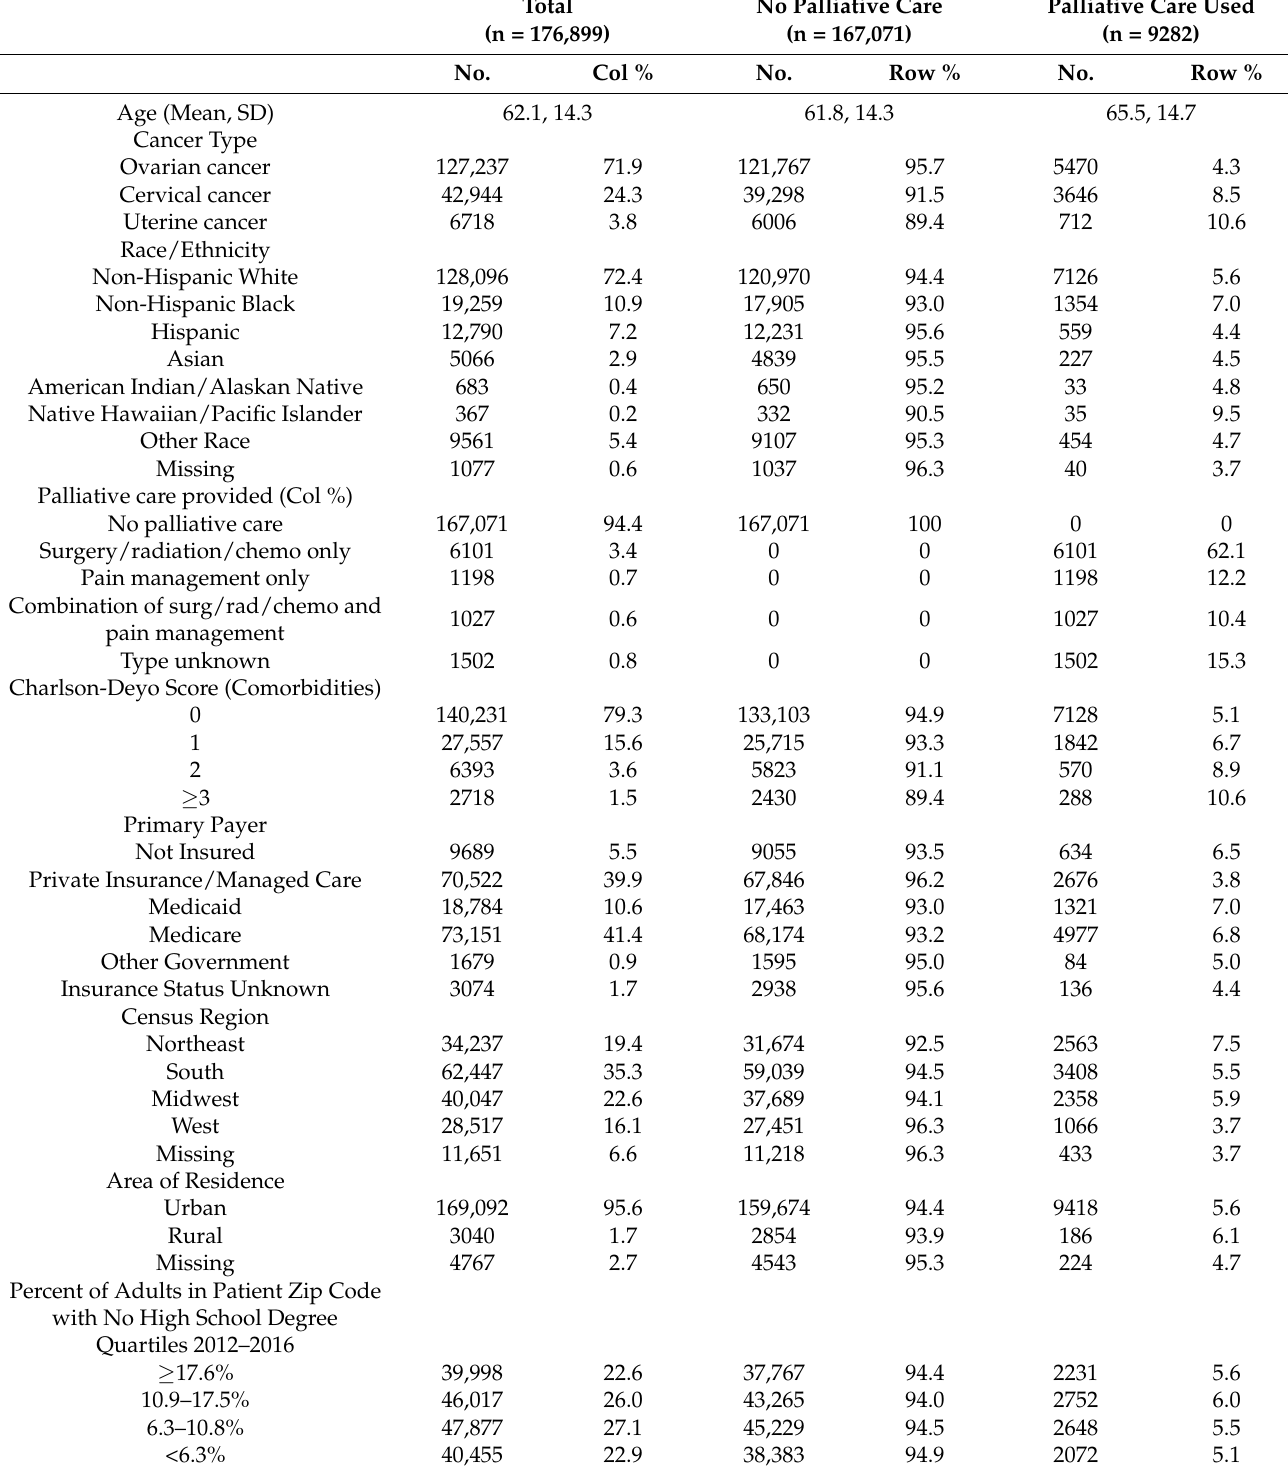
Table 1. Health Care Access Measures Among Metastatic Gynecologic Cancer Patients by Palliative Care Utilization (n =